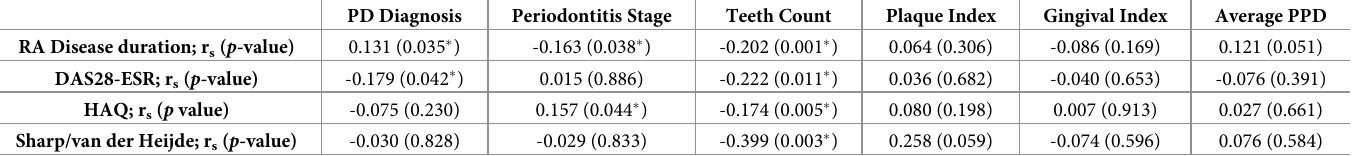
The amount and percentages of the participants that suffered from periodontitis and the breakdown of their stage and grade of periodontitis according to their serotype are shown in Table 4. The Chi-squared test showed a statistically significant difference between the stage of periodontitis experienced by ACPA-positive and ACPA-negative participants ( χ 2 (3, N = 46) = 10.28, p = 0.016). No difference in the stage and grade of periodontitis was found between participants who were RF-positive and RF-negative. Table 3. Correlation between the RA parameters compared to the PD